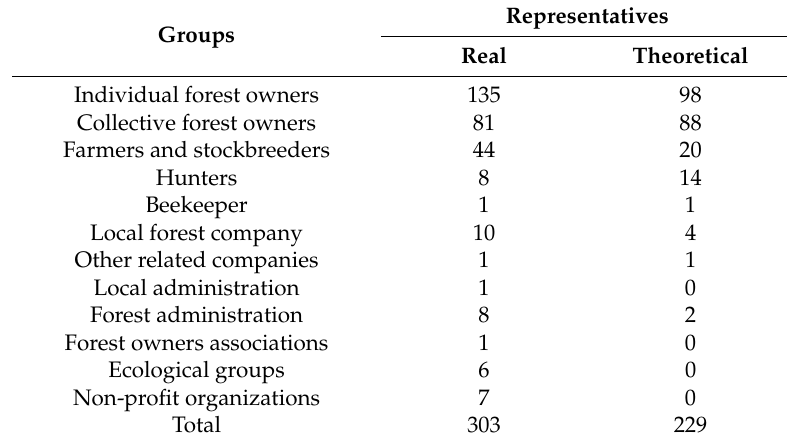
Table 3. Initial real and theoretical distribution of representativity in the participation process.